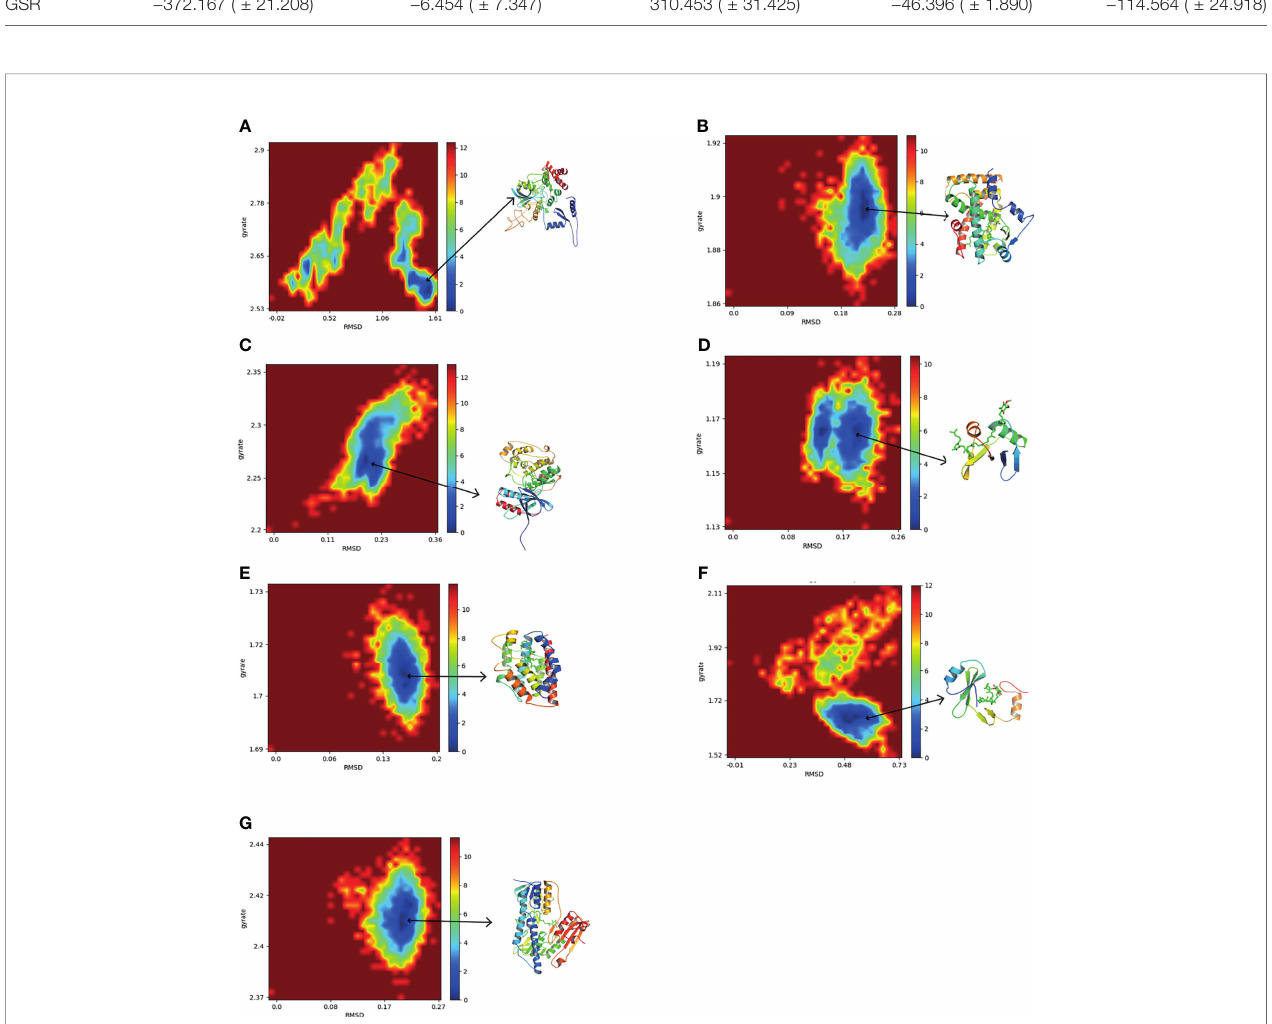
FIGURE 8 | The two-dimensional FEL as a function of Rg and RMSD (de fi ned in the text) for the complexes along 30 ns MD simulations. Snapshots from minimum energy wells were extracted. (A) CAT-CoQ10 complex. (B) PPARA-CoQ10 complex. (C) MAPK14-CoQ10 complex. (D) SQSTM1-CoQ10 complex. (E) HMOX1- CoQ10 complex. (F) GRB2-CoQ10 complex. (G) GSR-CoQ10 complex.